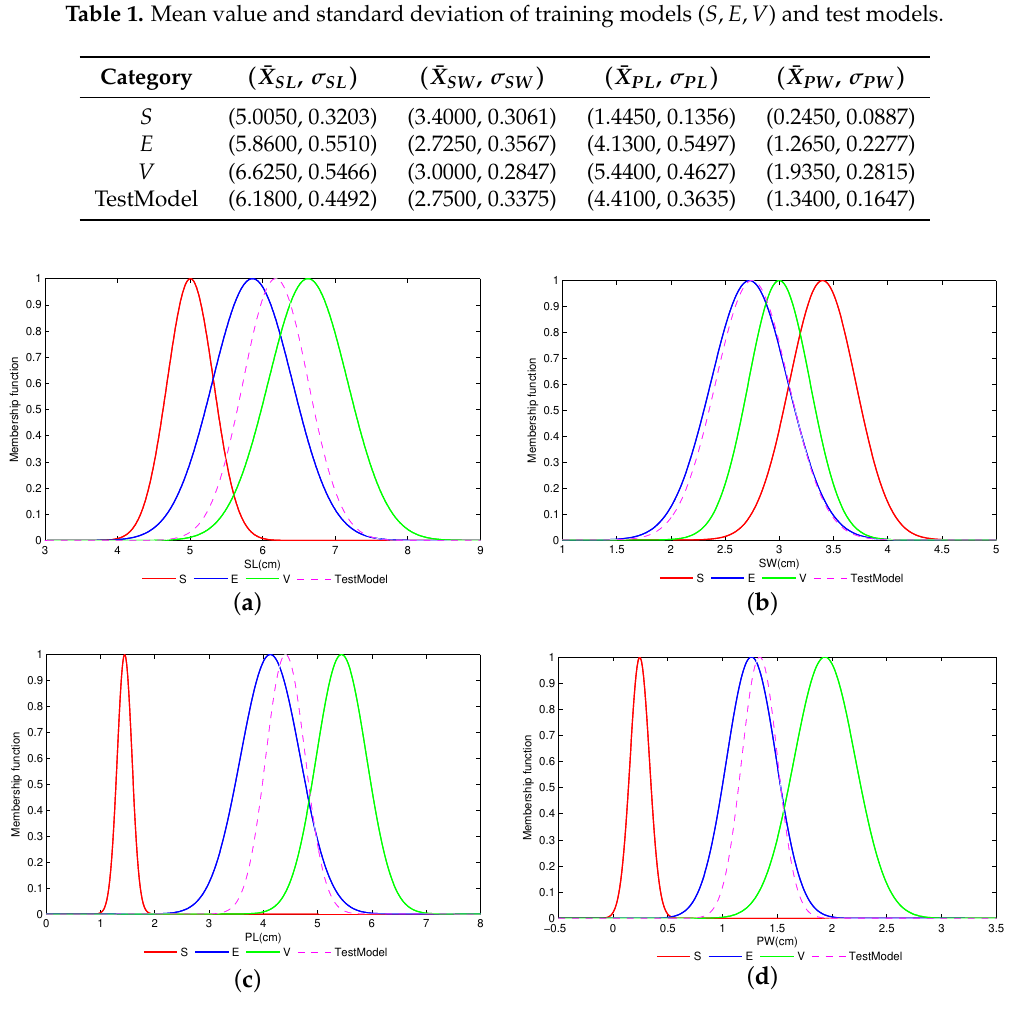
Figure 3. Training models and test models of four attributes. ( a ), ( b ), ( c ), ( d ) depicts training models and test model under attribute SL , SW , PL , PW ,